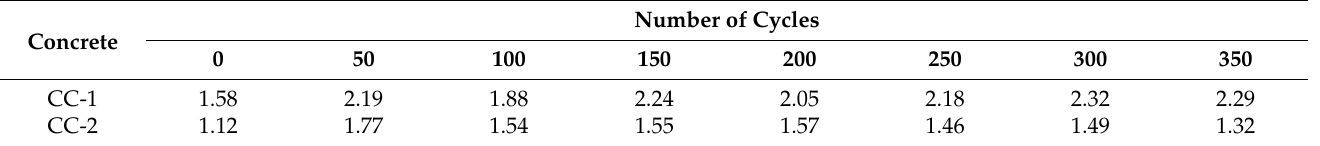
Table 10. Characteristics of the change in the relative measure of the dispersion of the average compressive strength of concrete CC-1 and CC-2—scheme B.